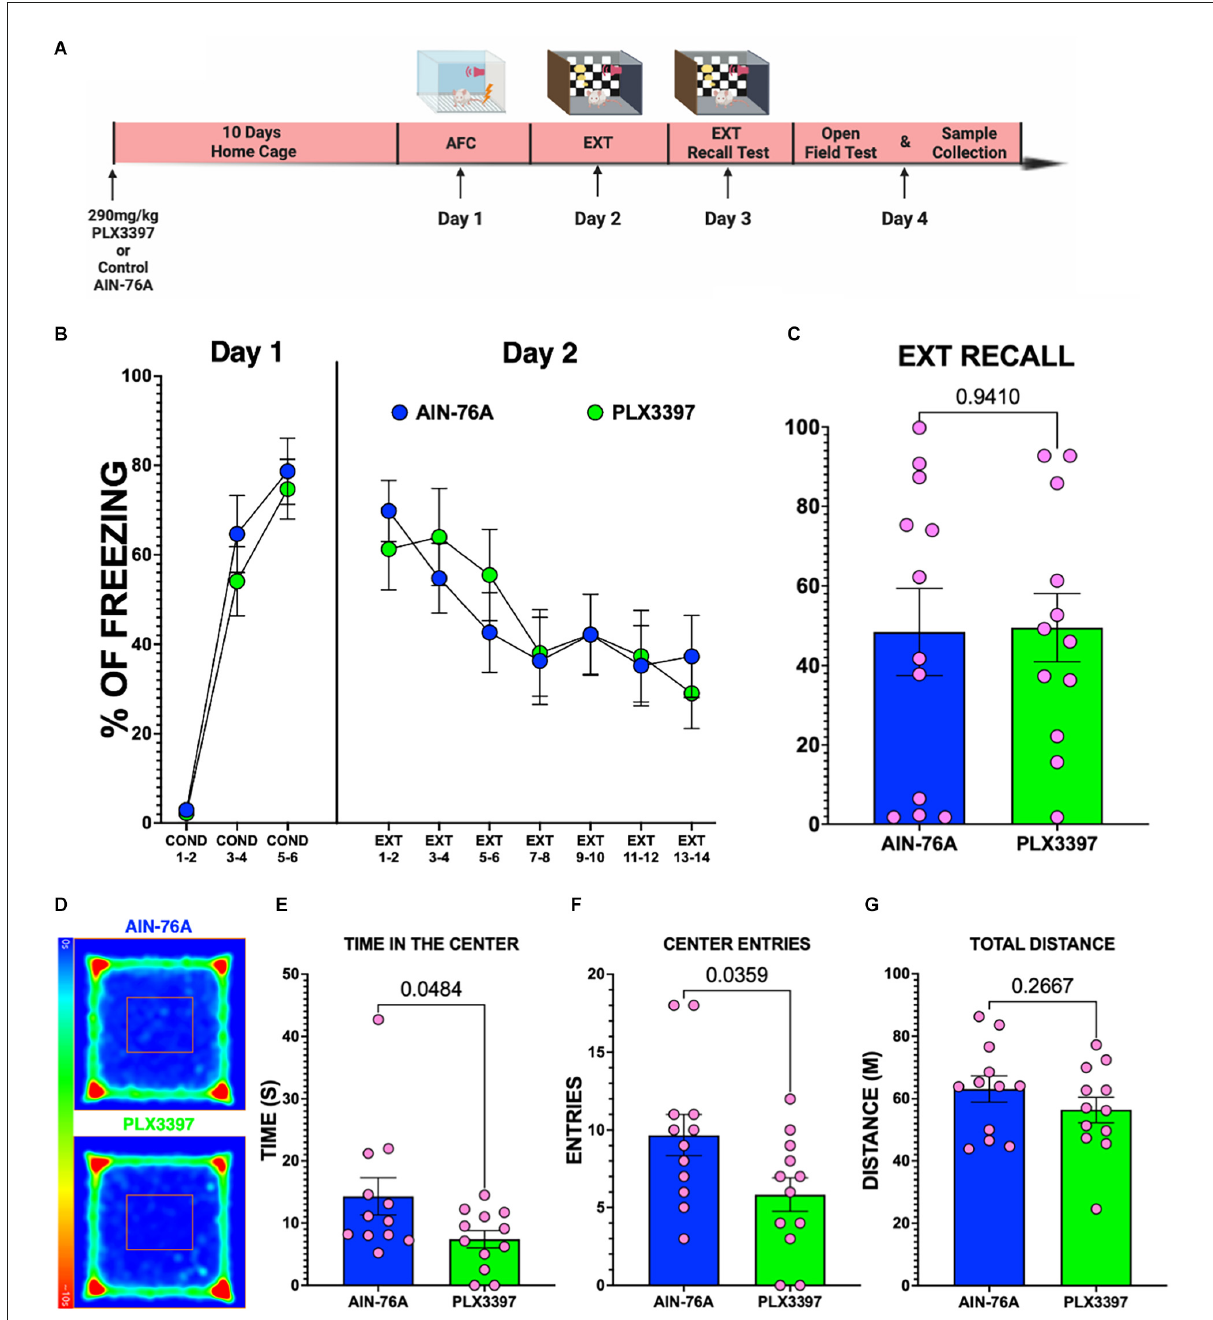
FIGURE5 Oral administration of PLX3397 alone does not disrupt fear, but reduces the time spent in the center of the OFT in female rats. (A) Experimental timeline. (B) Percent freezing of female rats across the behavioral paradigm. (C) Percent freezing during EXT-Recall on Day 3 of female rats (unpaired t-test, two-tailed; n = 12 female rats per group). (D) Average heat maps of the center of the body of female groups during the OFT. (E–G) Graphs of the time in the center, number of entries to the center of the arena, and the total distance traveled for the female rats (unpaired t-test, two-tailed; n = 12 female rats per